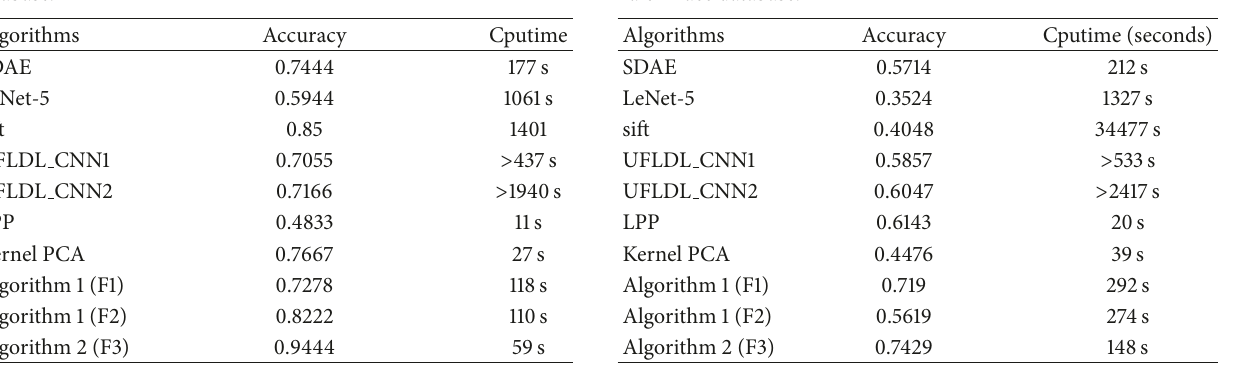
Table 1: The results of comparison experiments on subAR face database.